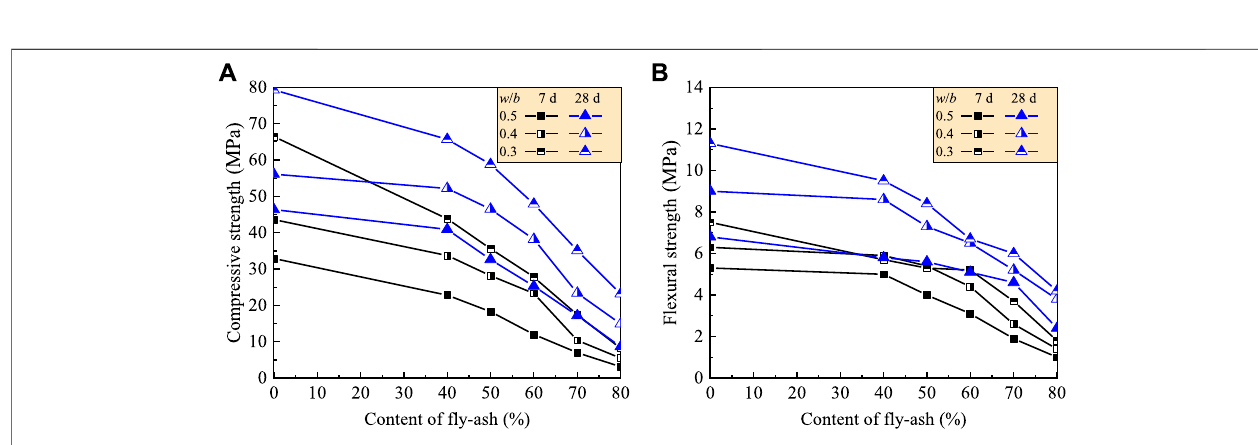
FIGURE 2 | Changes in strength with content of fl y ash: (A) compressive strength; (B) fl exural strength.